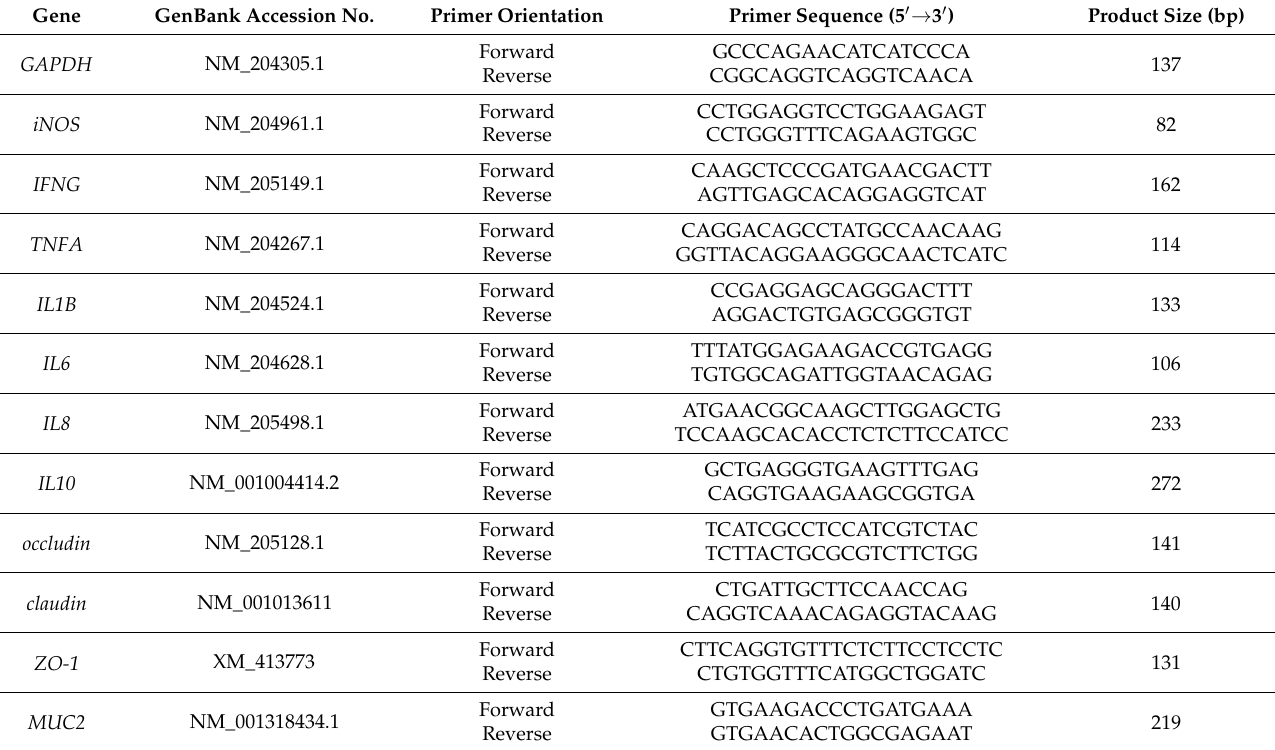
Table 2. Gene-specific primers for related